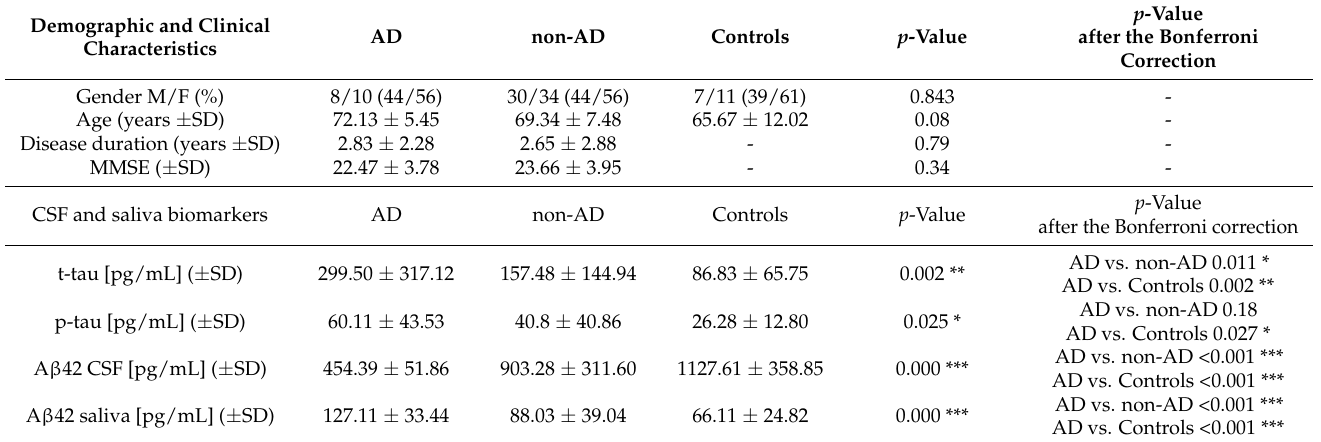
Table 1. Demographic, clinical, and laboratory parameter data of all enrolled